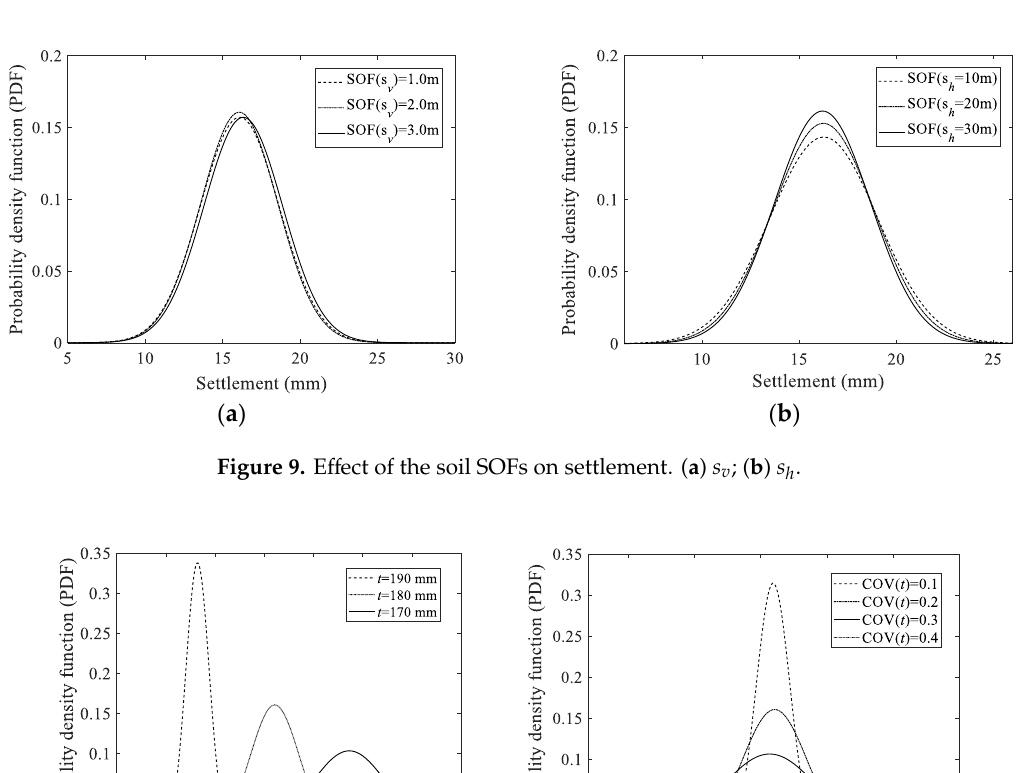
Figure 8. Effect of the soil COVs on settlement. ( a ) COV( c ); ( b ) COV( φ ); ( c ) COV( E ).